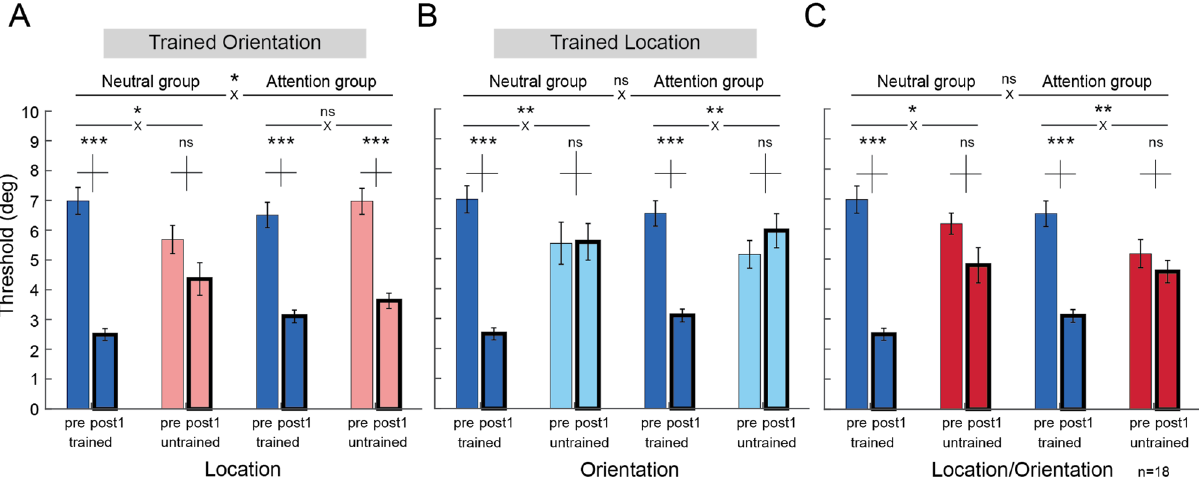
Figure 4. Threshold comparisons of Pre-test versus Post-test 1 between the Neutral and Attention groups. The trained condition was compared with the ( A ) untrained location, ( B ) untrained orientation, and ( C ) untrained location and orientation between the two groups. Learning transfer was found only in the untrained location in the Attention group ( A ), but not in the other untrained conditions ( B , C ) of either group (n = 9 per group). * p < 0.05; ** p < 0.01; *** p < 0.001. Error bars represent ± 1 within-subject SEM. Vertical bars above paired comparisons represent ± 1 SEM for the mean threshold difference between Pre-test and Post-test